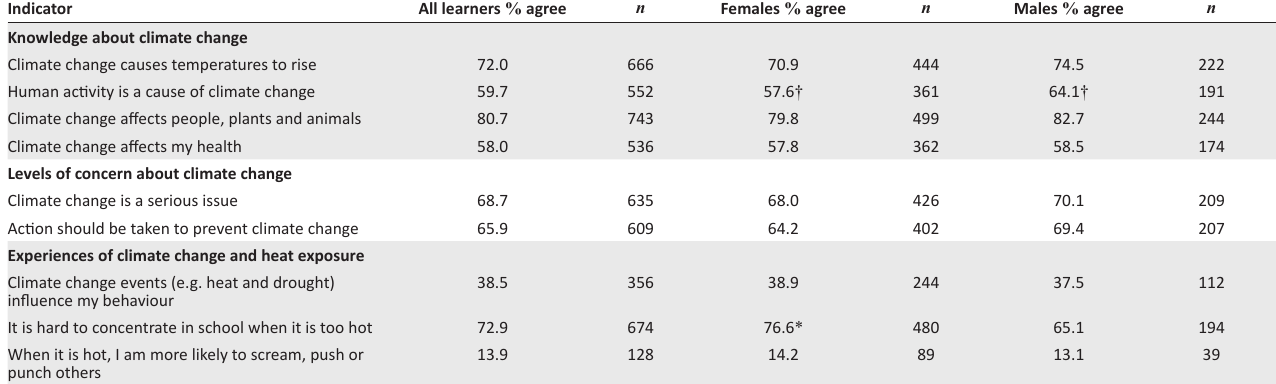
TABLE 1: Knowledge, concerns and experiences of climate change among secondary school learners in the Western Cape, South Africa. Indicator